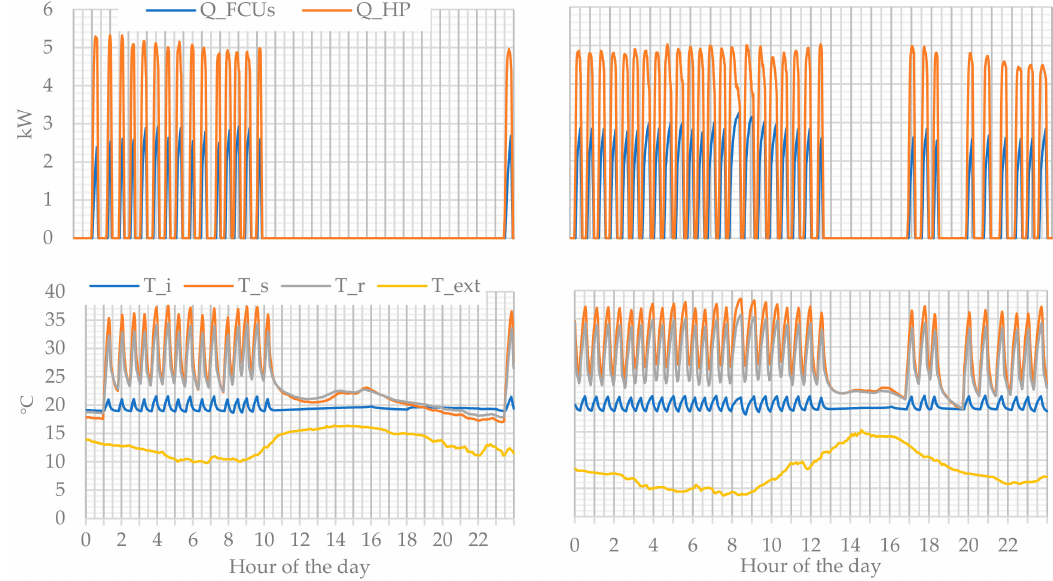
Figure 6. Typical mild ( left ) and cold ( right ) days under MOD#1 (23-Dec.,